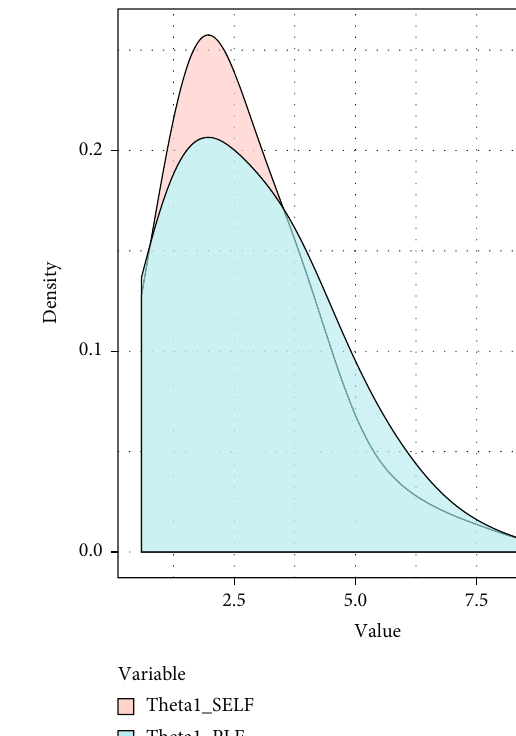
under TKA for dataset-1. 1